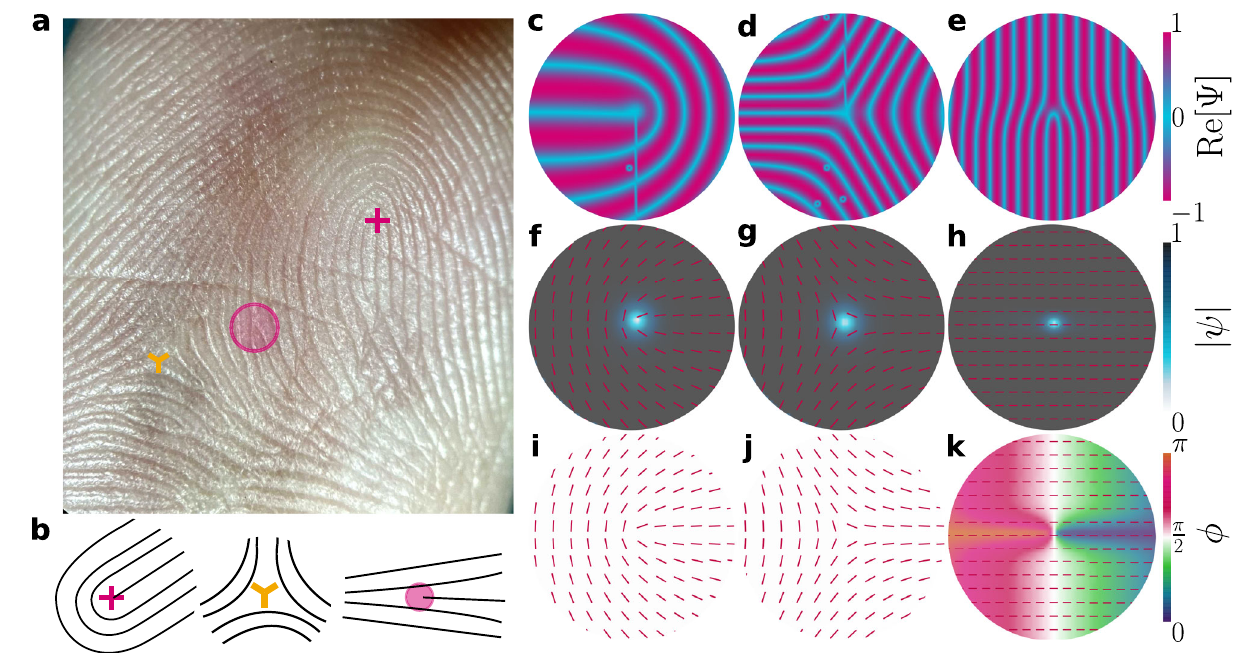
Fig. 1 | A catalog of defects in 2D smectics. a Single defects marked on a high resolution photo of a fi ngerprint. +1/2 disclination, − 1/2 disclination and edge dis- location marked by red cross, yellow trilateral and red circle, respectively. b Schematics of (left) +1/2 disclination, (center) − 1/2 disclination and (right) dis- locations. c – k Simulations of defects for model parameters A = − 1 (lamellar state),